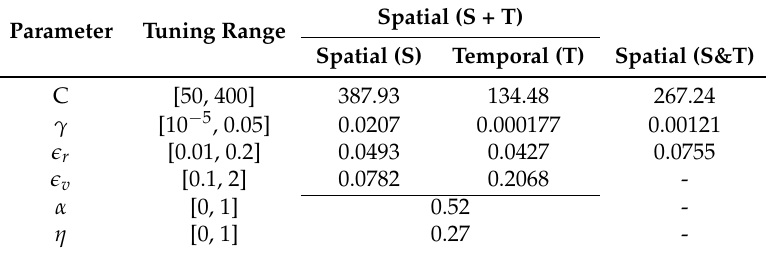
Table 3. Parameter